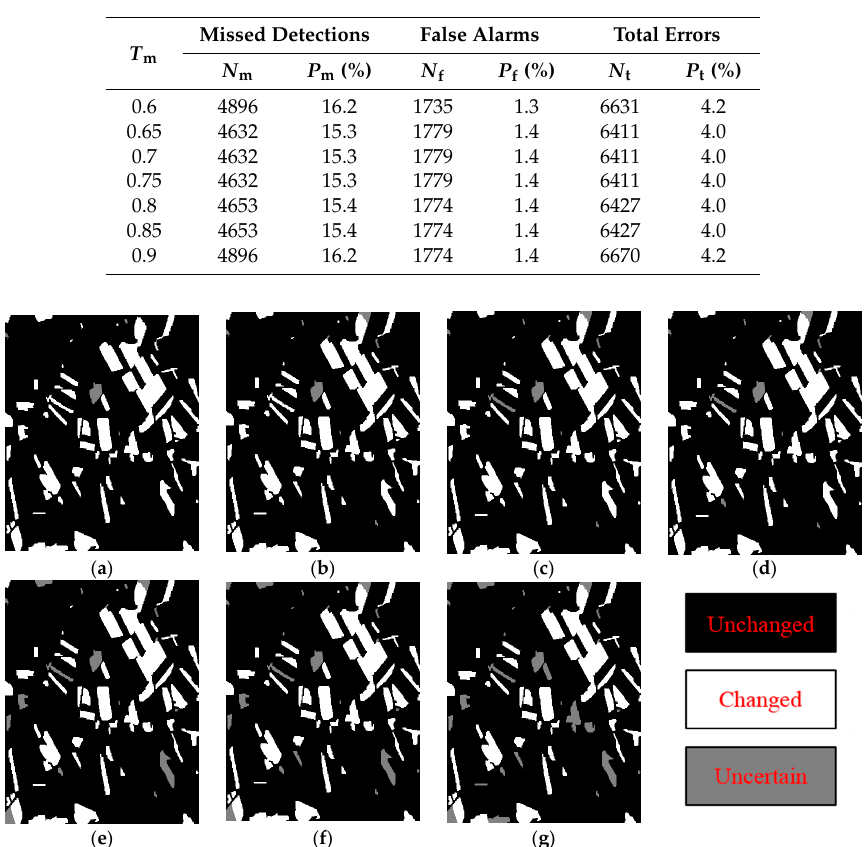
Figure 5. Results of first scale uncertainty analysis for the thresholds of ( a ) 0.6; ( b ) 0.65; ( c ) 0.7; ( d ) 0.75; ( e ) 0.8; ( f ) 0.85 and ( g ) 0.9 using the first segmentation map for Q = 64.